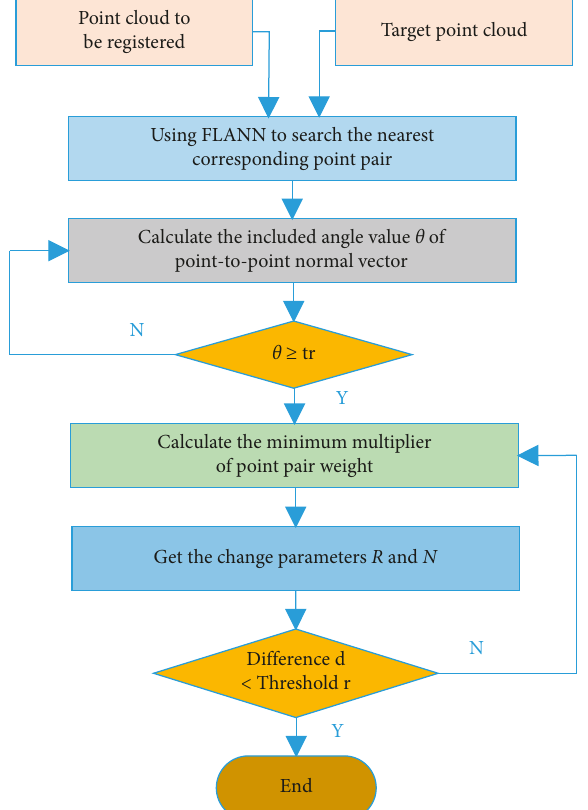
Figure 4: Fine registration process.